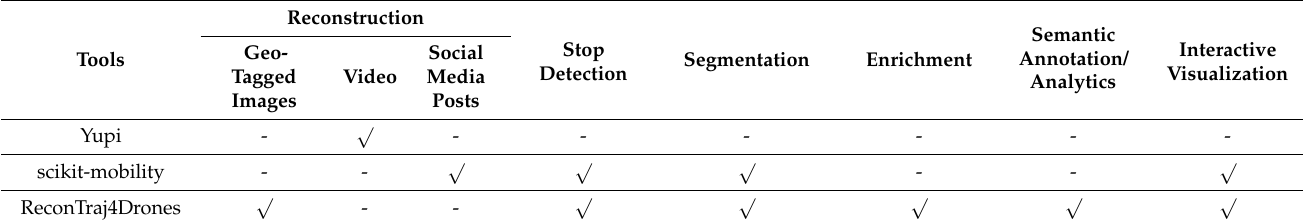
Table 1. Comparison of available tools for trajectory